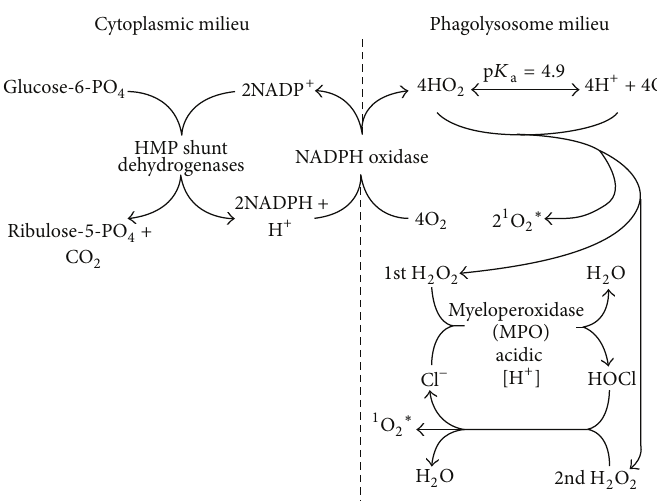
Figure 1: Schematic depiction of neutrophil HOCl and 1 O 2∗